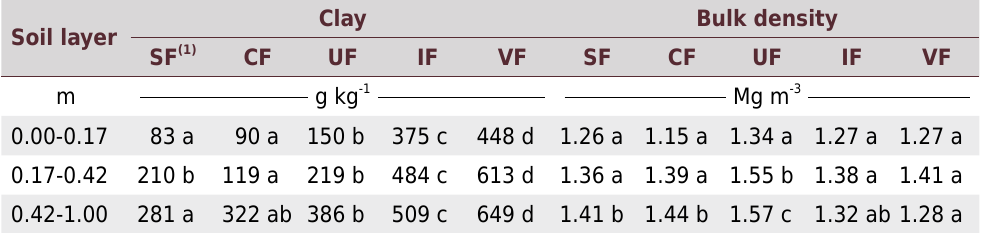
Table 3. Profile distribution of clay content and bulk density of soils from different forest areas (n = 3) Soil layer